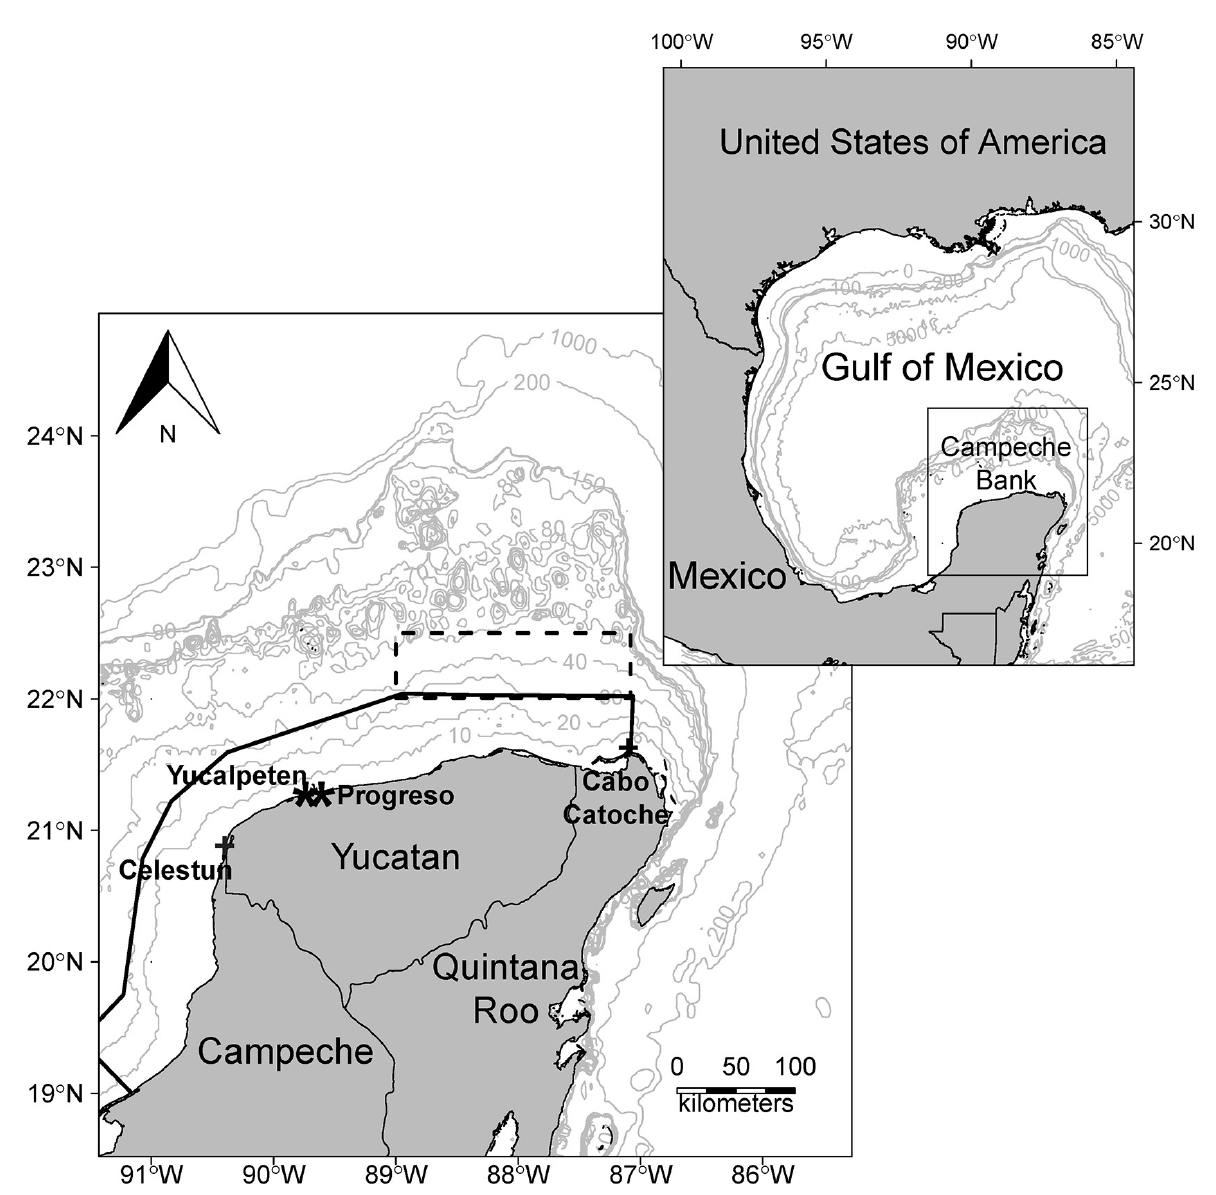
Fig. 1. – Campeche Bank and the location of the ports of Progreso and Yucalpeten, Yucatan, Mexico. Fishing area described for O. maya (continuous line) and O. americanus ) (dotted line) (Source: DOF 2018, Sauer et al. 2021). The asterisk represents the ports where the interviews were carried